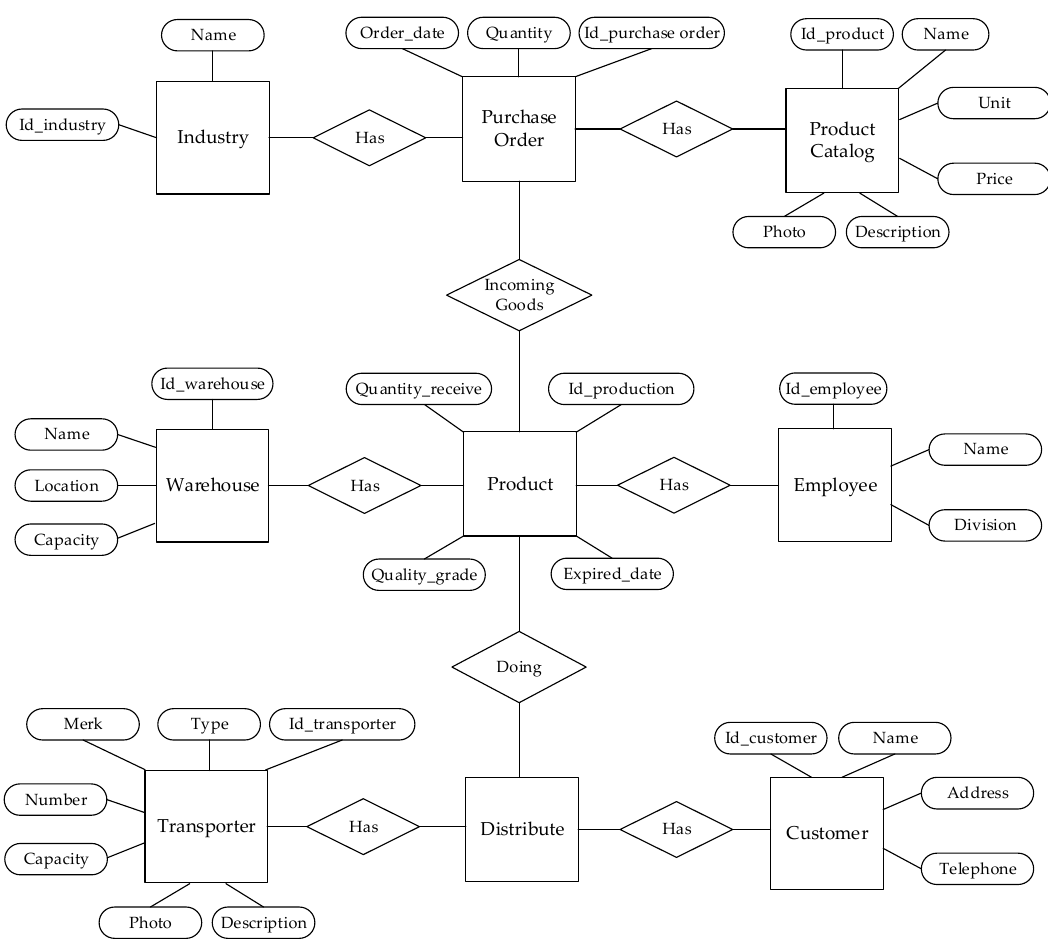
Figure 5. Entity relationship diagram (ERD) of internal traceability at the distributor.